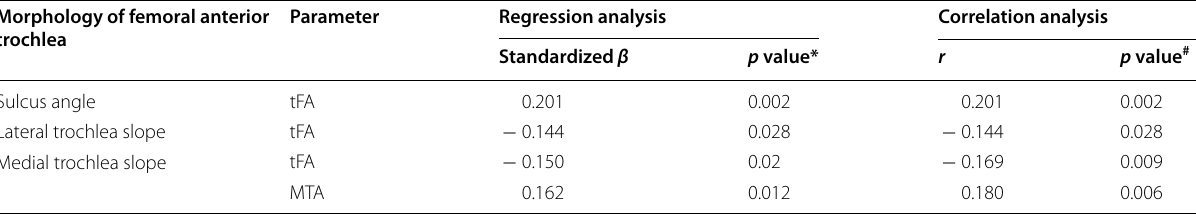
Table 3 Stepwise regression analysis and Pearson correlation analysis of the anterior femoral trochlea morphology for OA patients Morphology of femoral anterior trochlea